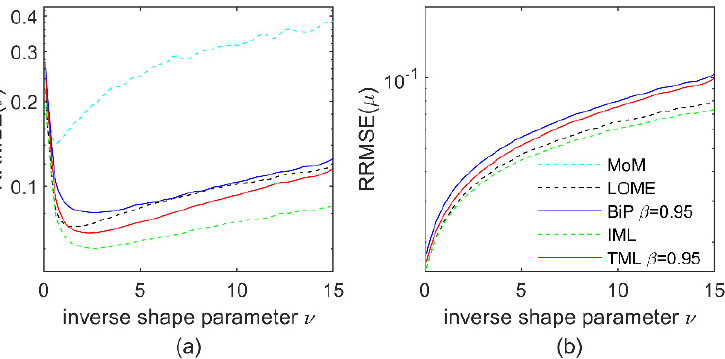
Figure 4. Performance comparison of the five estimation methods in the case without outliers when ν alters from 0.1 to 15: ( a ) RRMSEs of the inverse shape parameter; ( b ) RRMSEs of the scale param- eter.